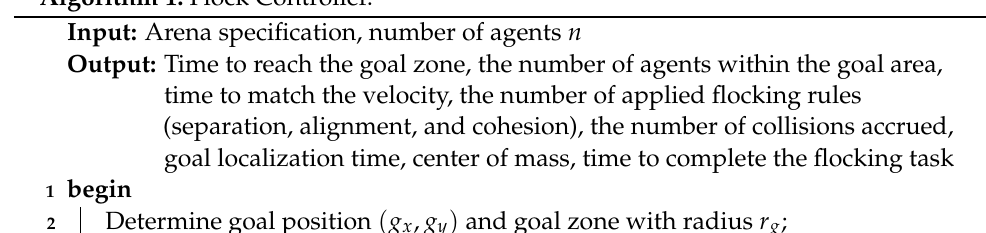
Algorithm 1: Flock